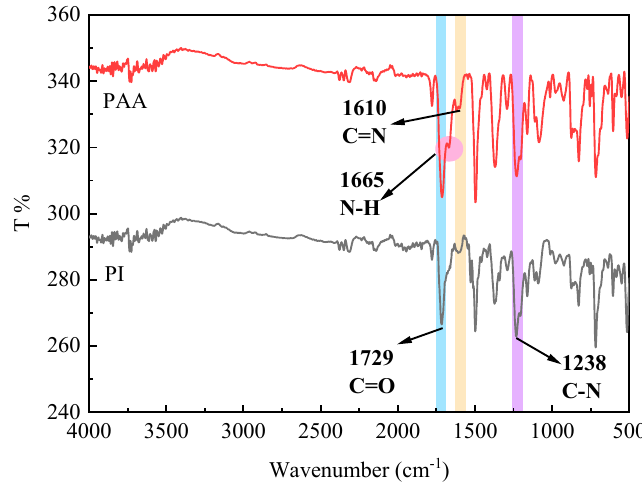
Figure 2. FT − IR spectrum of PAA and PI.